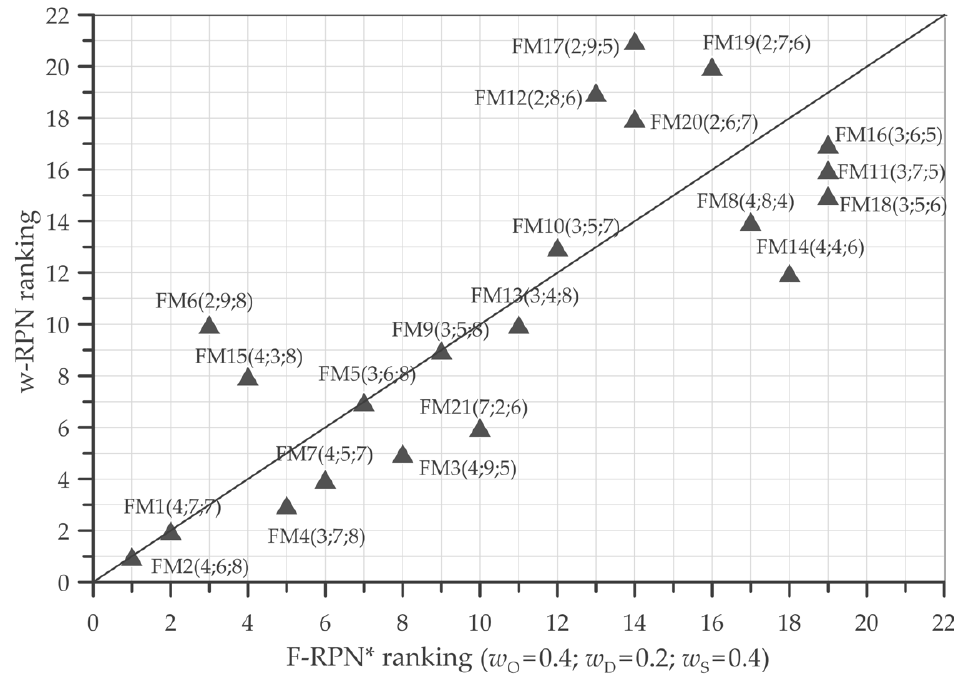
Figure 5. Comparison of rankings weight-RPN vs. Fuzzy-RPN* both obtained using weights of Equation (4).